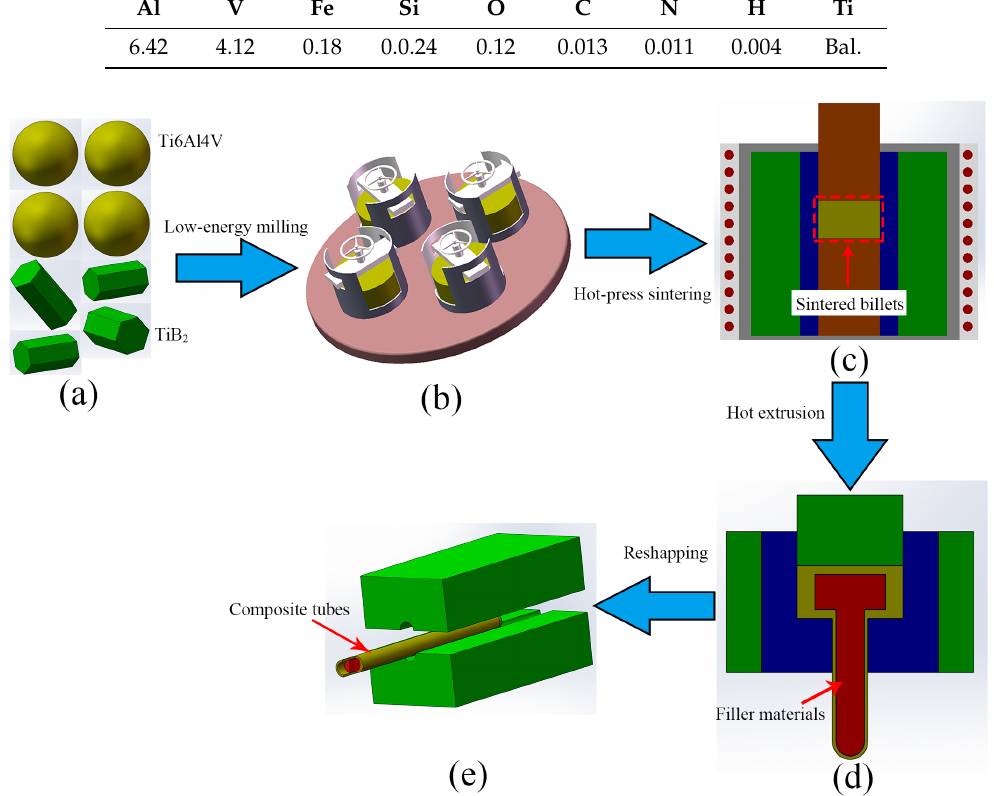
Figure 1. Schematic illustration of procedures to fabricate TiBw/Ti6Al4V composite tube: ( a ) Ti6Al4V and TiB 2 powders; ( b ) the low-energy milling; ( c ) the sintering process; ( d ) the extrusion process; ( e ) the reshaping